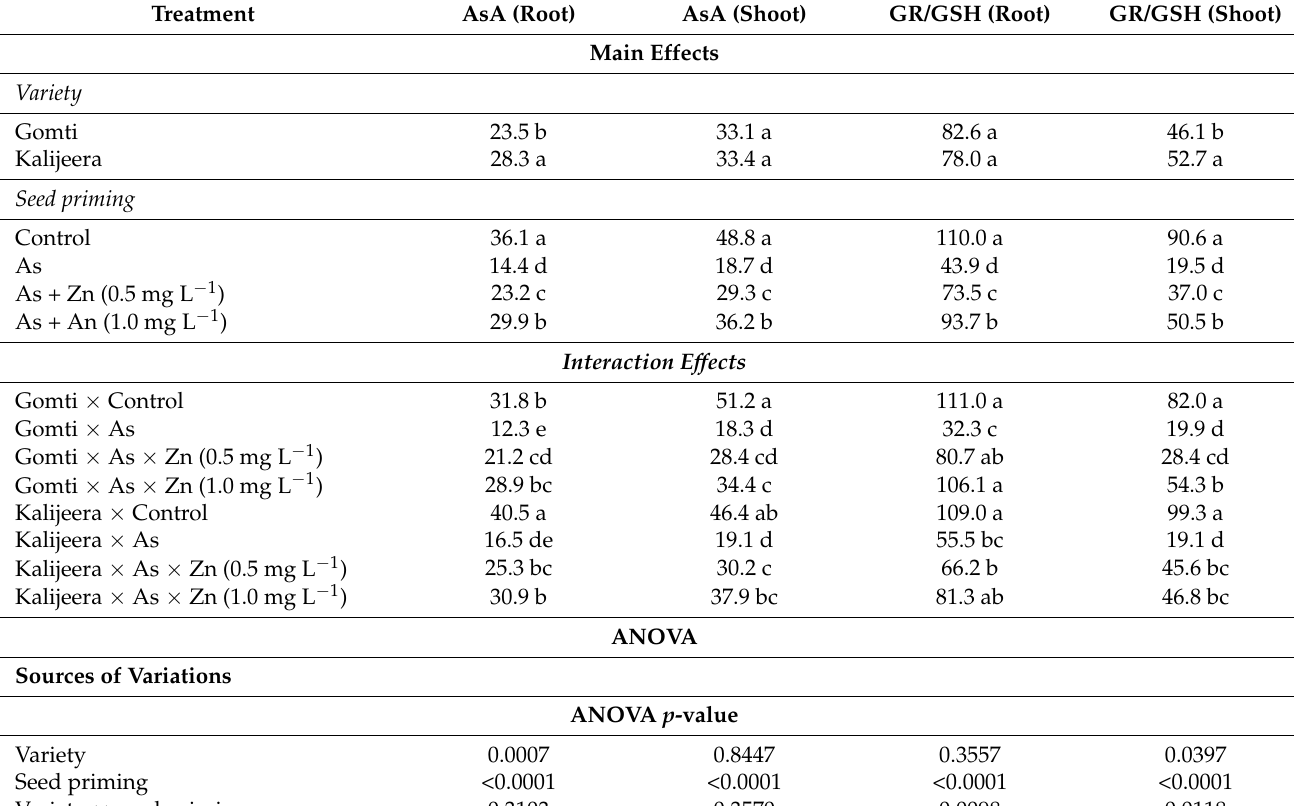
Table 3. AsA and GSH content in roots and shoots of rice